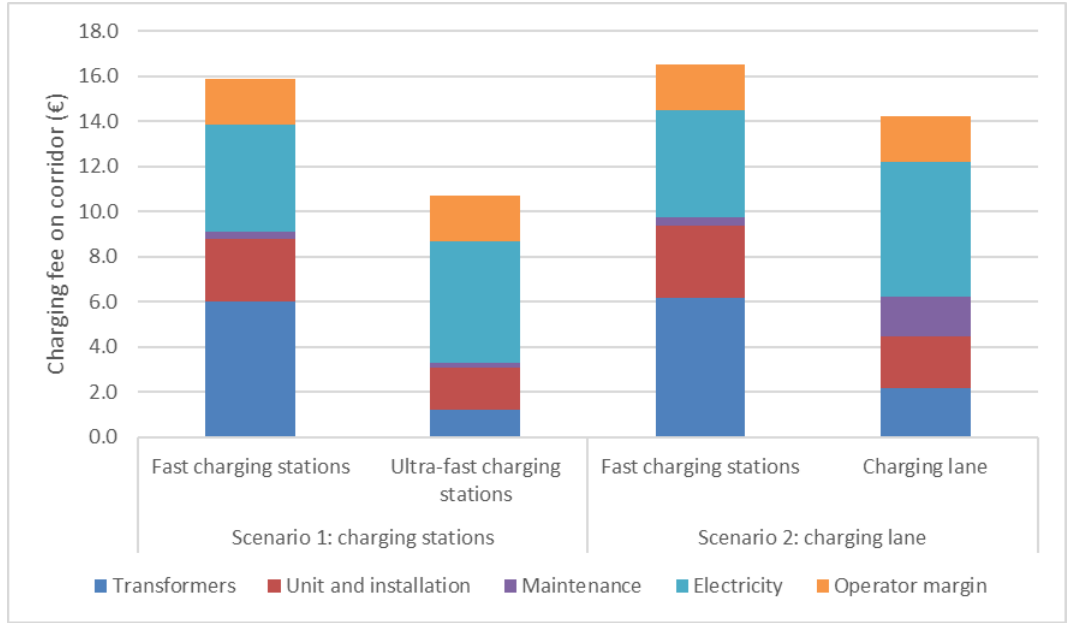
Figure 3. Breakdown of the charging fee for 200 km.